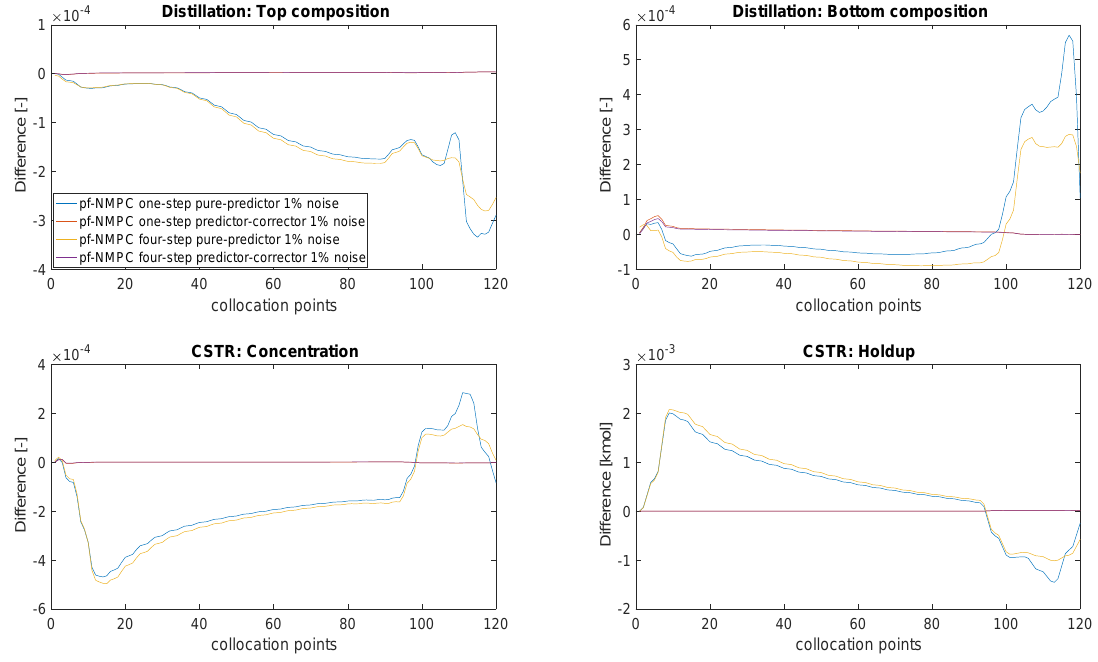
Figure 3. The difference in predicted state variables between ideal NMPC (iNMPC) and path-following NMPC (pf-NMPC) from the second iteration.